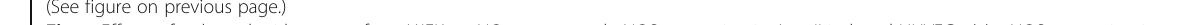
control group; 2, Ang II (10 − 5 mol/l) group; 3, Ang II (10 − 5 mol/l) + AqE (0.15 mg/ml) group; 4, Ang II (10 − 5 mol/l) + AqE (0.3 mg/ml) group; 5, Ang